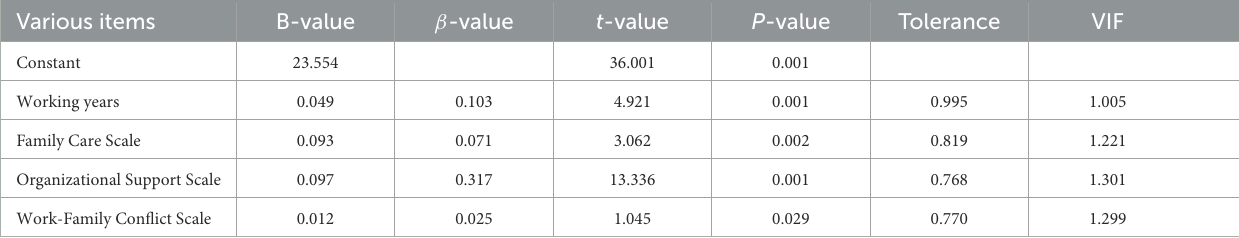
TABLE 6 Multiple stepwise regression results of nurses’ family caring, perception of organizational support, and work-family conflict on burnout ( n = 2,014). Various items